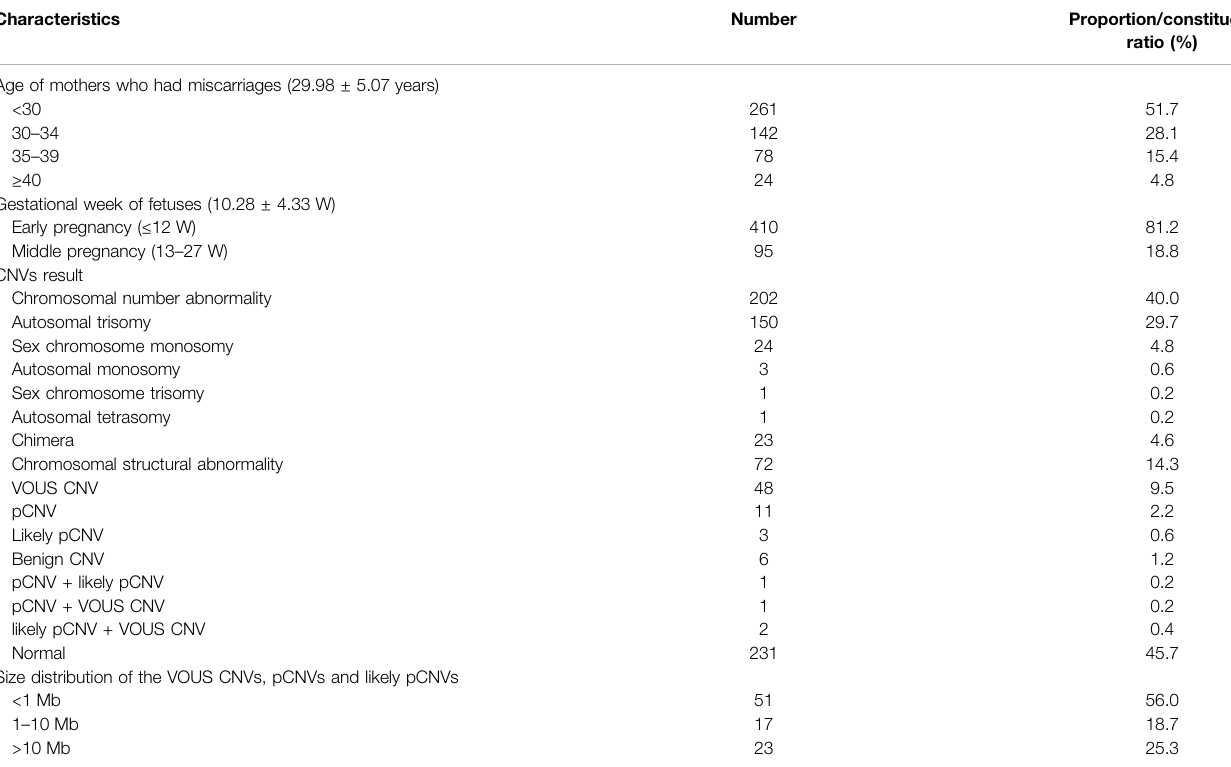
TABLE 1 | Demographic variables and baseline characteristics of mothers who suffer from miscarriages and overall CNV results of fetuses.